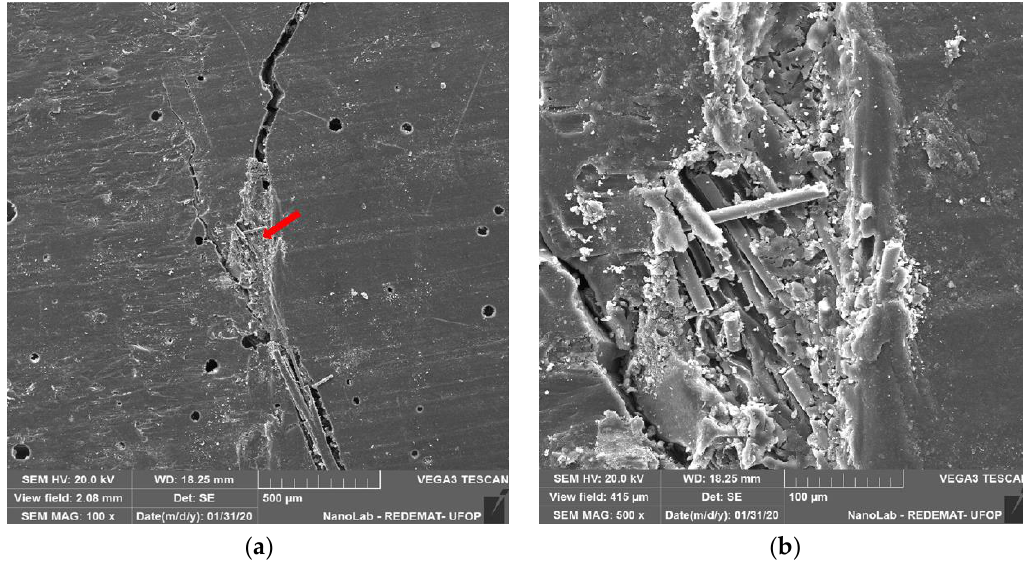
Figure 22. Flexural surface of the matrix of epoxy resin and polypropylene fibre ( a ) 100×; ( b ) 500×